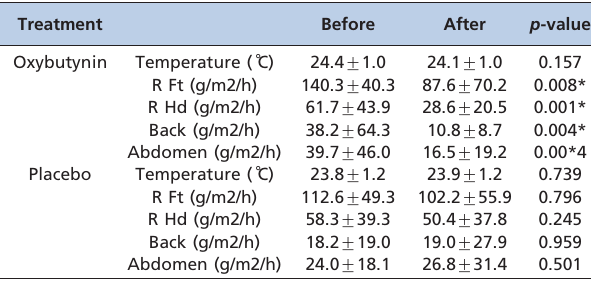
QoL: Quality-of-life questionnaire; HH: Hyperhidrosis; A: Adjusted. Table 4 - Oxybutynin and placebo groups - Means and standard deviations of the transepidermal water loss measurements (g/m2/h) before and after the intervention.